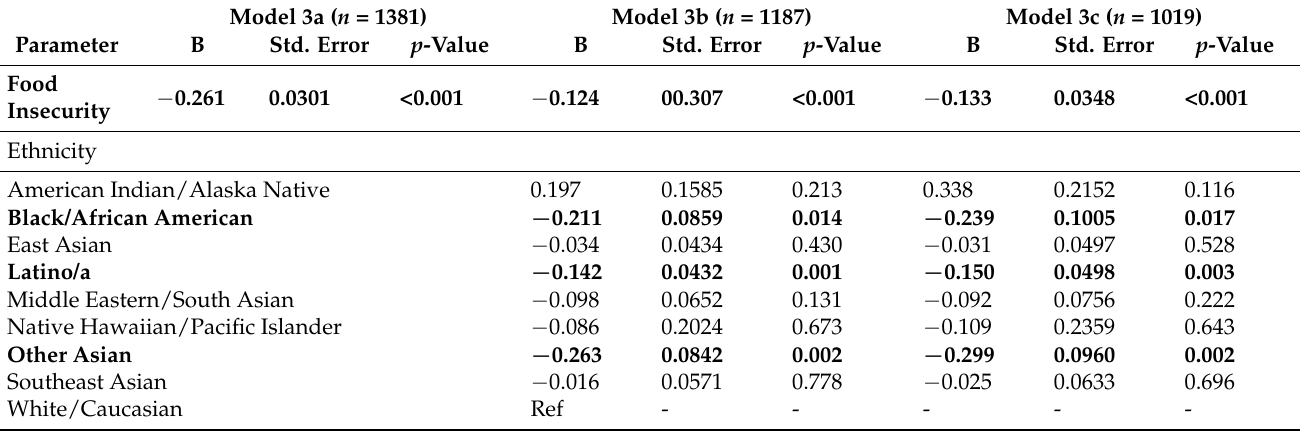
Table 6. Regression Model 3: Multiple Linear Regression of Food Insecurity’s Association with of